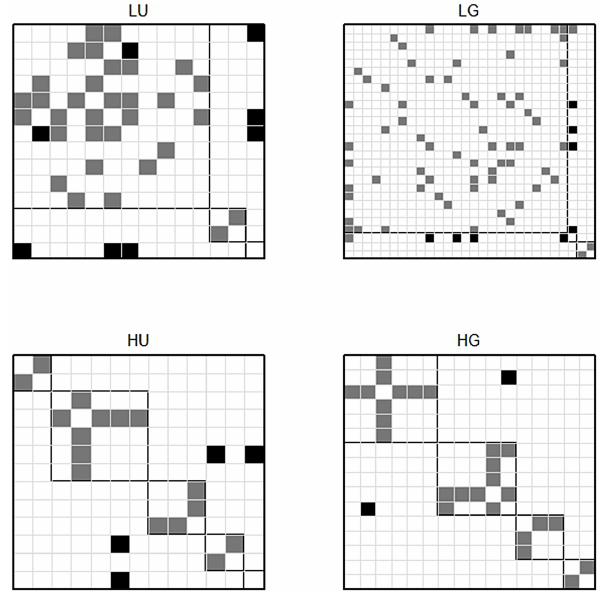
Figure 2. Plant–plant spatial association networks of the plant com- munity at four sites in middle Ebro Valley, Spain. Study site refers to the sites with the lowest (L) and the highest (H) aridity index values and whether a site was grazed (G) or ungrazed (U). Matrices were divided in partitions, which represented the different types of vege- tation patches in the community. Partitions were created following a structural balance criterion. Positive associations (grey squares) fell within, and negative associations (black squares) fell outside of par- titions. Matrices were based on the transect number 6 at each study